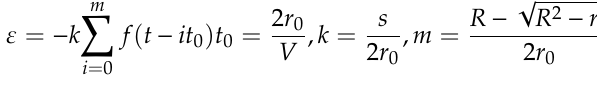
Figure 4. Schematic diagram of theoretical calculation model of induced electromotive force: ( a ) Liquid slug passing through the single coil; ( b ) liquid slug passing through the multi-turn coil.